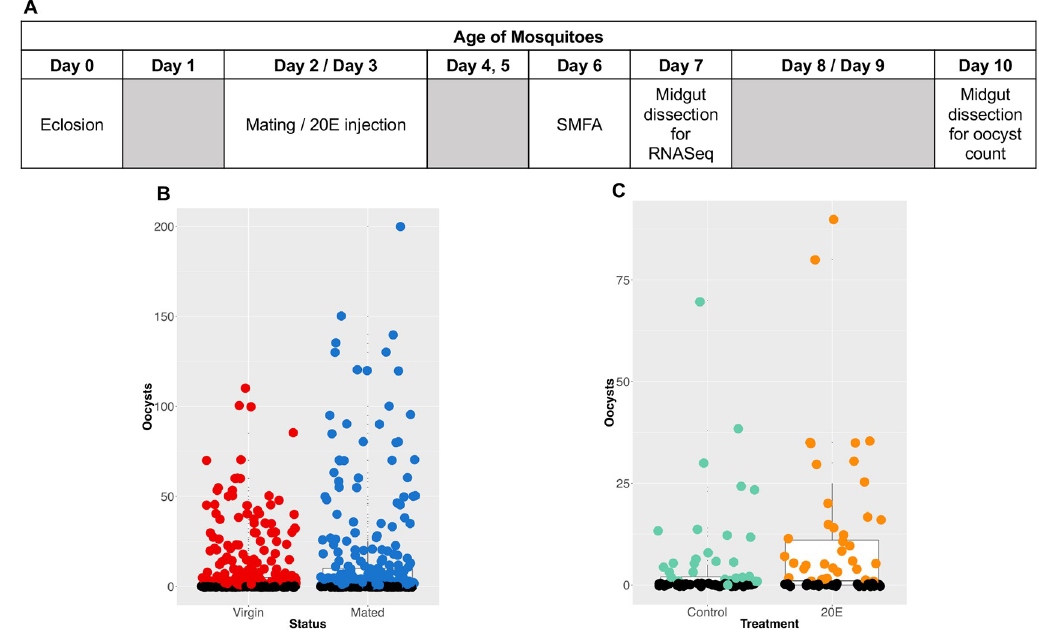
Fig 1. Mating and 20E injection both significantly enhance female susceptibility to Plasmodium falciparum infection. (A) Experimental design schematic for mating, 20E, bloodfeeds (i.e., SMFAs or Standard Membrane Feeding Assays), and RNASeq experiments. (B) Each dot is the number of P . falciparum oocysts counted in a single midgut dissected on day 10 post blood-feed. Data represented here are from 10 independent feeds (individually displayed in S1 Fig). Black dots are uninfected midguts (oocysts = 0). Boxplots indicate the median and 25-75th percentiles. Mated females show significantly higher infection intensity ( p = 0.005) and prevalence ( p = 0.039) compared to virgin females. (C) 20E injected females show significantly higher infection intensity ( p < 0.001) and prevalence ( p = 0.01) compared to control injected females.